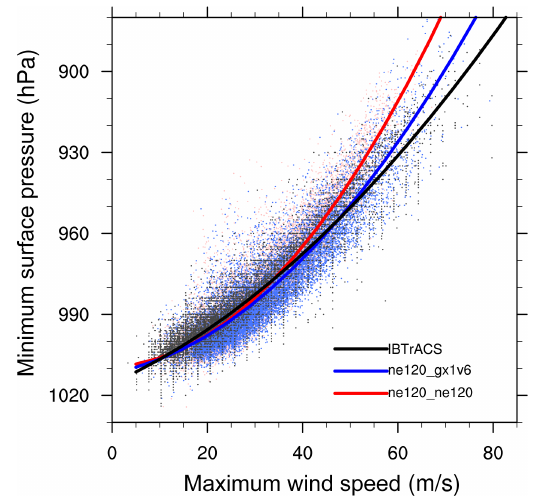
Figure 3. Storm minimum surface pressure vs. maximum 10m wind speed relationship with quadratic least squares fit (solid lines) for the CAM5 simulations and IBTrACS observations from 1980 to 2005. Note that 3-hourly output is used for the model simulations, while the IBTrACS data are